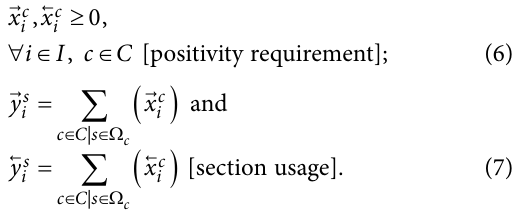
Table 1. Variables and parameters of the base capacity model Indices i, j, c, s, t Train, train, corridor, section, time period Sets C, I, S Set of corridors, train types, sections Decision